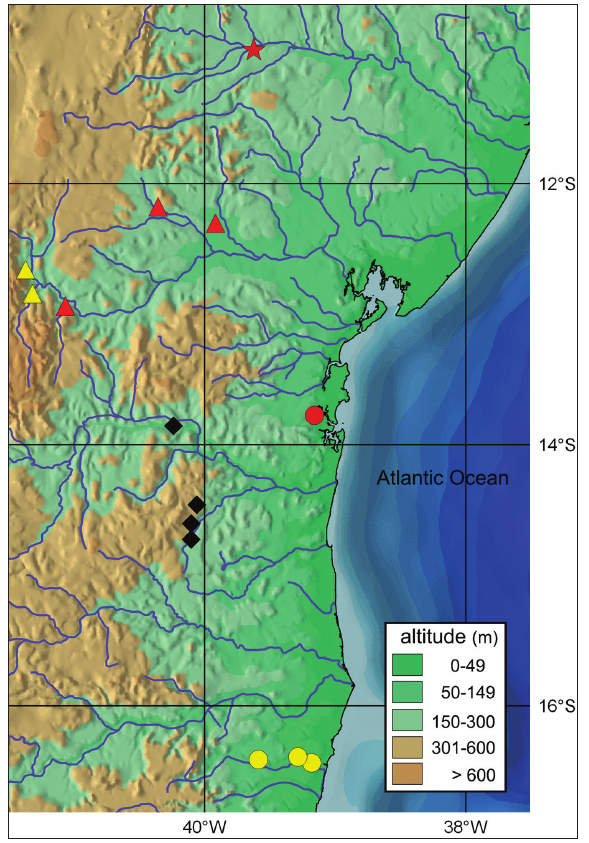
Figure 3. Geographical distribution of the ‘ Geophagus ’ brasil- iensis species group in northeast Brazil: red star, G. itapicuru- ensis ; red triangle, G. obscurus ; yellow triangle, G. diamantin- ensis ; red circle, G. santosi ; black diamond, G . multiocellus ; yellow circle, G . rufomarginatus . Raw data set source was obtained from Natural Earth public domain (http://www.natu-